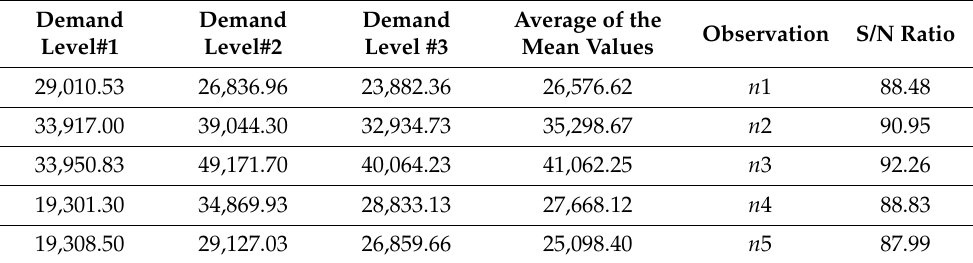
Table 7. Results from the 9 experiments and S/N